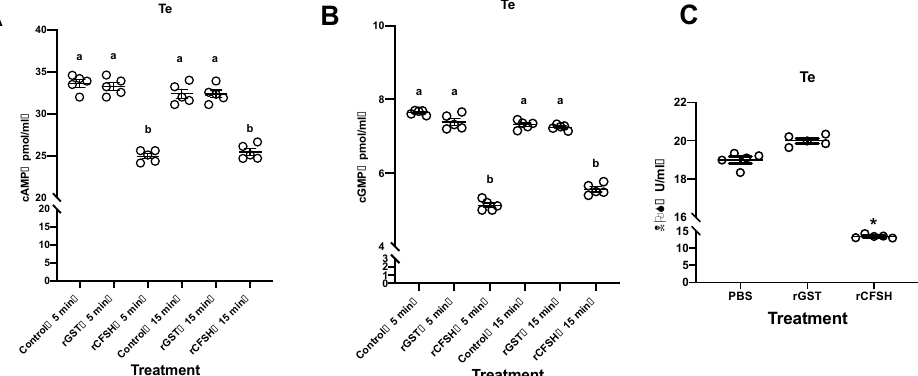
Figure 7. Changes in cAMP, cGMP, and NOS levels were detected after the rPtCFSH isolated culture of testis. ( A ) Changes in cAMP levels in the testis after rPtCFSH treatment compared to rGST, PBS group. Groups with the same letter do not differ significantly, and different letters indicate significant differences. ( B ) Changes in cGMP levels in the testis after rPtCFSH treatment compared to rGST, PBS group. Groups with the same letter do not differ significantly, and different letters indicate significant differences. ( C ) Changes in NOS levels in the testis after rPtCFSH treatment compared to rGST, PBS group. The scale bar is shown in the lower right corner. * indicates acceptance 0.01 < p <0.05. Vertical bars represent means ± SEM (n = 5). Significant differences among stages are indicated by different letter labels (one-way ANOVA followed by post hoc Tukey’s multiple group comparison p < 0.05).